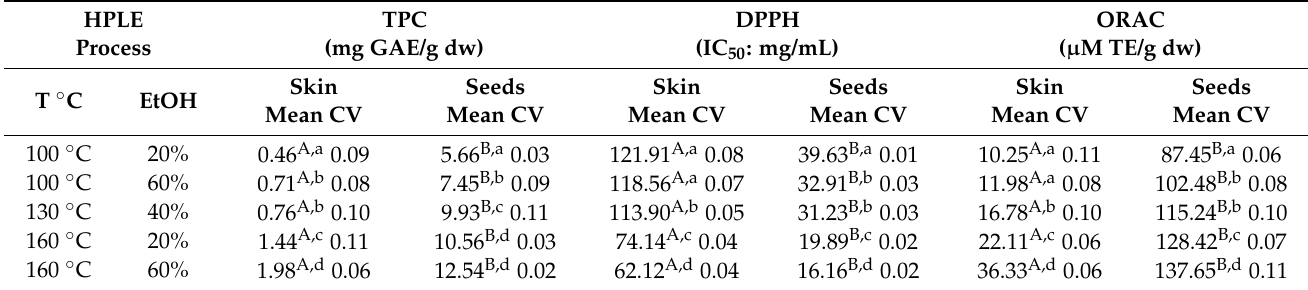
Table 1. Chemical characterization of extracts obtained by the HPLE